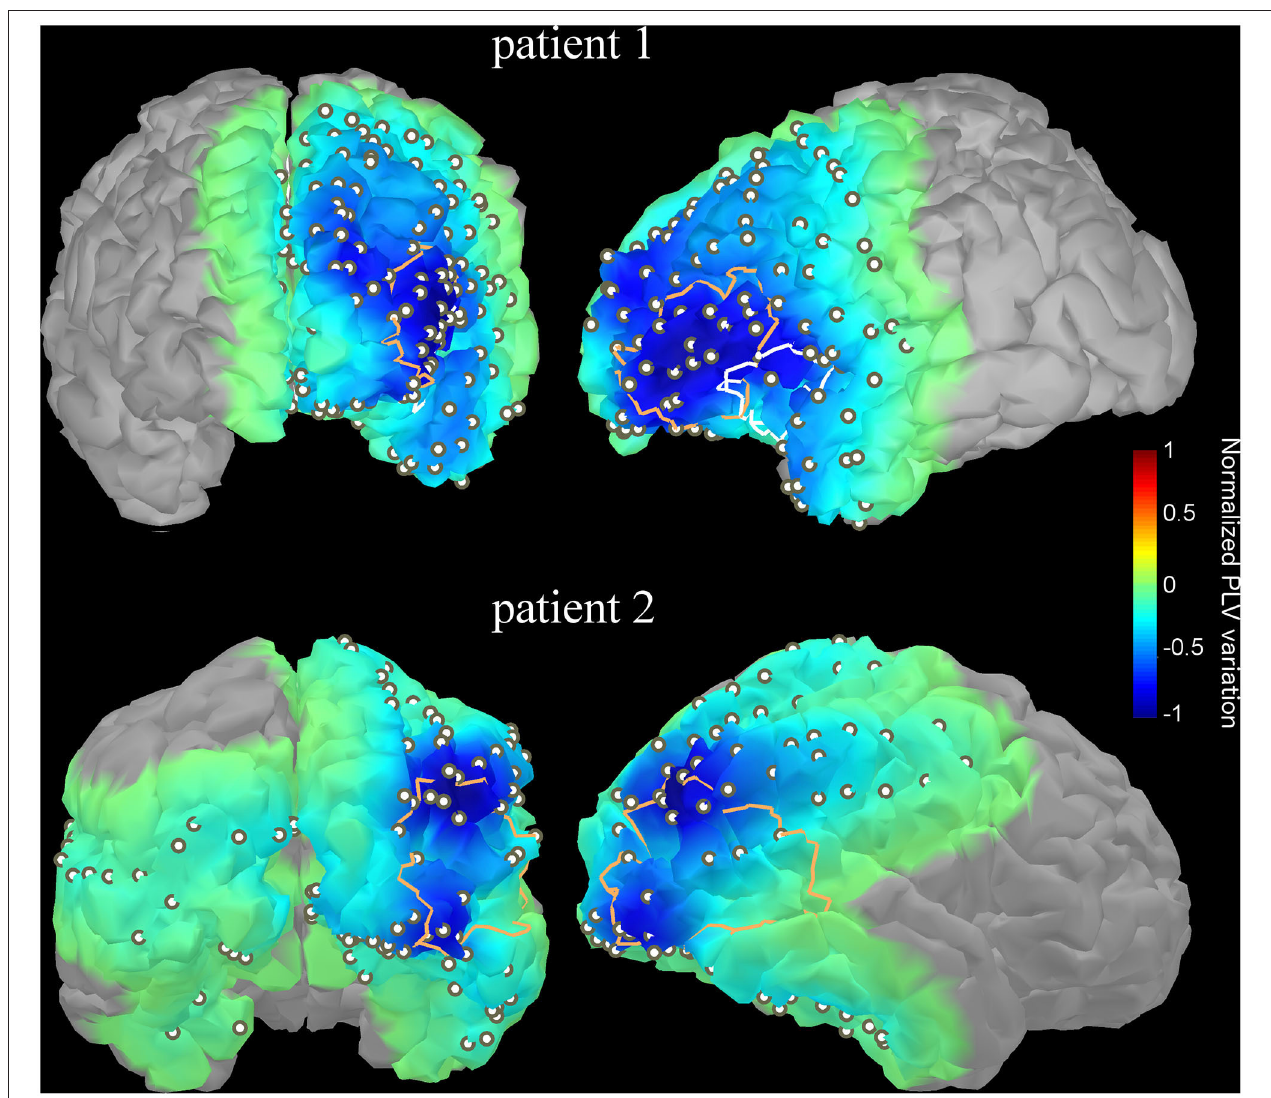
FIGURE 6 | Variation of functional connectivity in the high gamma band (60–120Hz) as measured with PLV index at the IED peak with respect to baseline (-1 to − 0.5s) for two illustrative patients. The variation index was computed for each electrode contact then interpolated over the underlying cortical surface using an in-house algorithm. The resection site targeted by a later surgery is overlaid as a thick contour. The first patient (upper row) had 2 surgeries; the first one targeted mainly the anterior insula (white contour line) while the maximal decrease of PLV was found in the lateral inferior frontal gyrus. The second surgery (orange contour line) targeted left orbitofrontal and frontal lateral regions, which was concordant with the sites of maximal PLV variation. For the second patient, the resected site (orange contour line) overlaps with the two sites with maximal PLV variation. The PLV projection onto the modeled cortex was threshold; only points on the projection of the cortex which account for 95% of the variance were